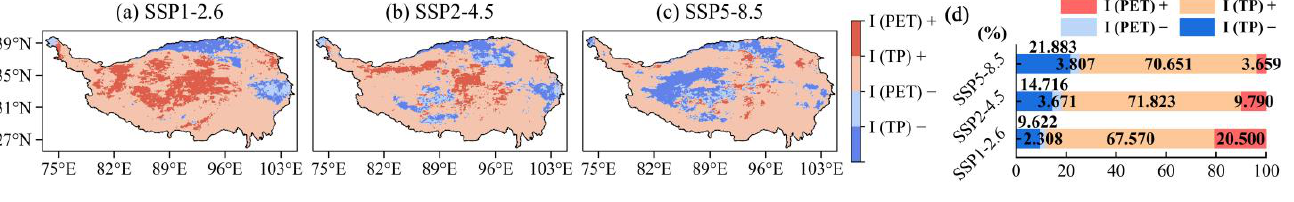
Figure 10. Dominant factors of drought intensity variation during HQ correction. ( a – c ) are SSP1-2.6, SSP2-4.5, and SSP5-8.5 scenarios, respectively. ( d ) is the statistical chart of ( a – c ). I (PET) + indicates that the increase in drought intensity is caused by changes in PET. Table 2. Statistics of spatial correction results in future scenarios (+ or − indicates the increase or decrease in variable and R is the area ratio). TP PET Drought Intensity TP PET Drought